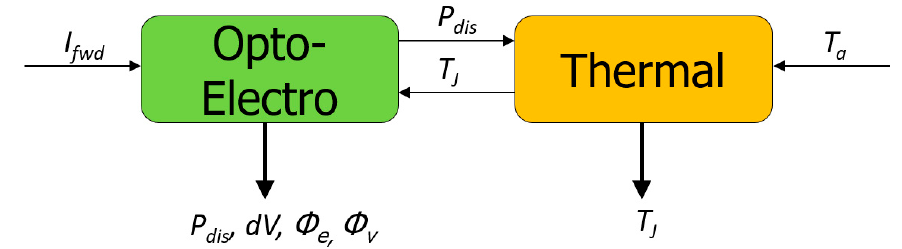
Figure 1. Co-simulation framework of a multi-domain LED compact model.